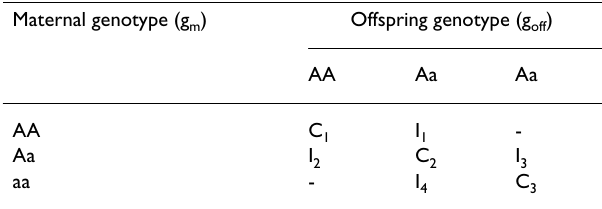
Table 1: Possible maternal and offspring genotype combinations under Mendelian inheritance Maternal genotype (g m )